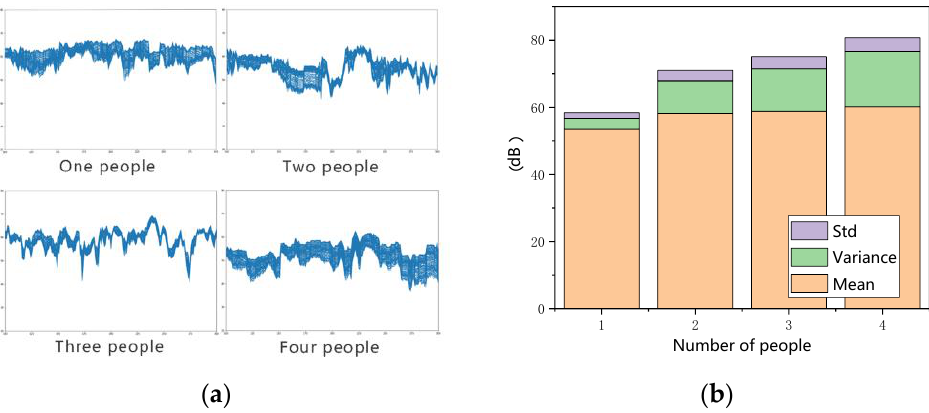
Figure 6. Comparison of subcarrier signals and signal eigenvalues: ( a ) CSI signals for different numbers of people; ( b ) Magnitude of change of characteristics.